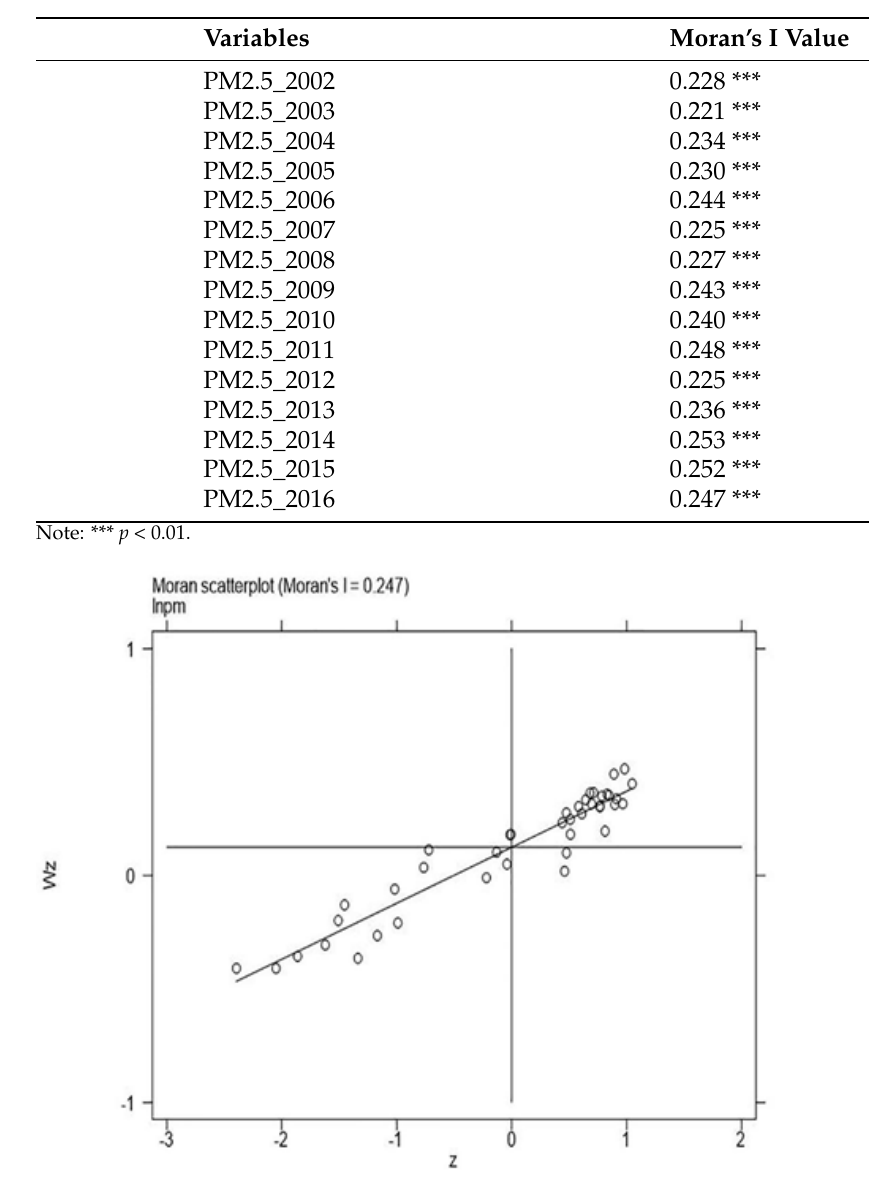
Table 5. Moran’s I value with spatial correlation estimation.